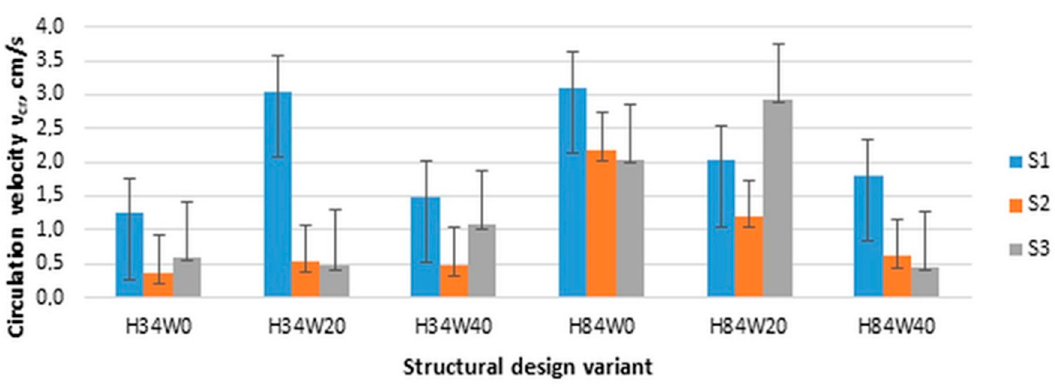
Figure 6. Circulation velocity of liquid v cr in the reactor in different measurement zones; point M1.